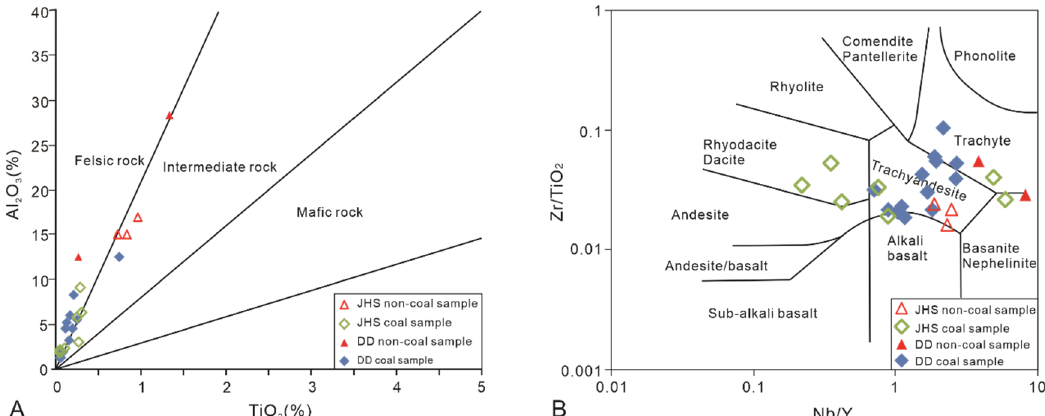
Figure 8. Plots of elements in the coal and non-coal samples from the Dongdong and Jinhuashan coal mines. ( A ) Plots of Al 2 O 3 vs. TiO 2 . ( B ) Diagram showing Zr/TiO 2 vs. Nb/Y ratios using the magma source discrimination diagram of Winchester and Floyd (1977) [48].